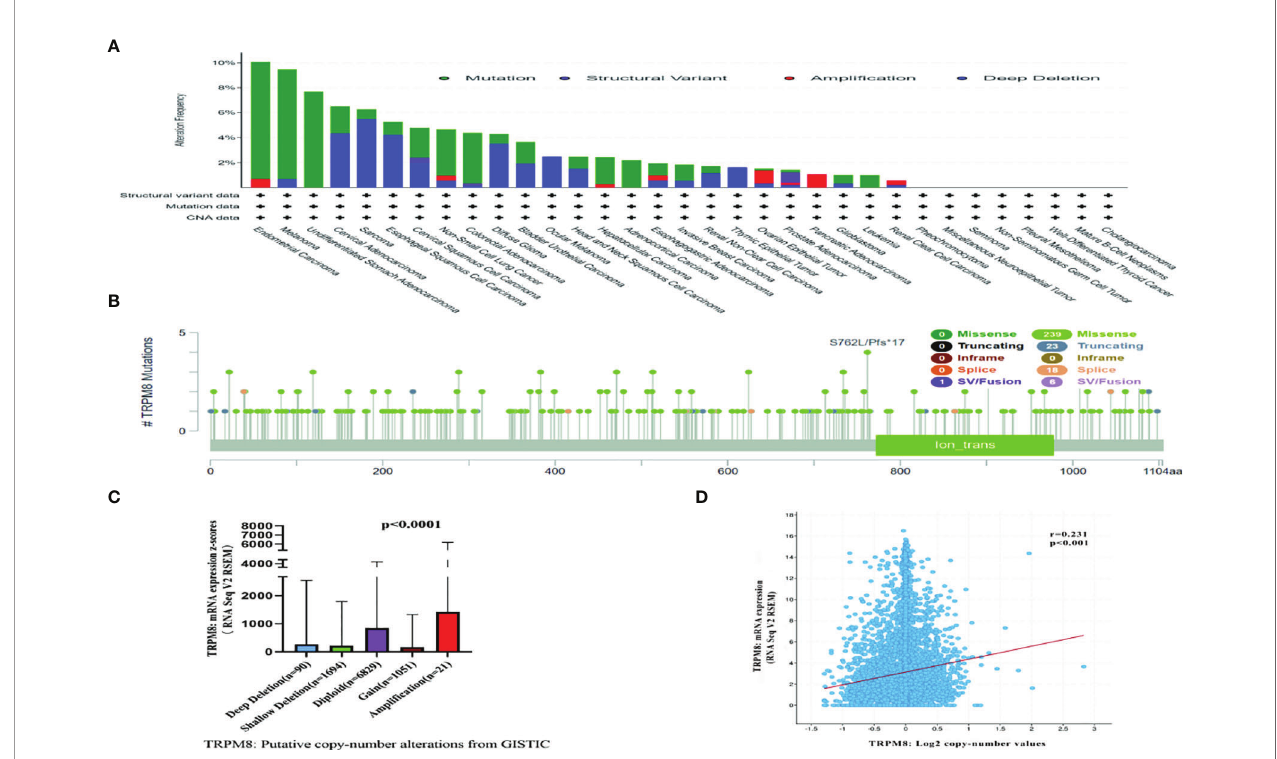
FIGURE 3 | Mutation of TRPM8, assessed by cBioPortal. Mutation frequencies are shown with the type of mutation (A) , and site of mutation (B) . Association between TRPM8 copy number and mRNA level, shown by dot plot (C) and correlation plot (D)